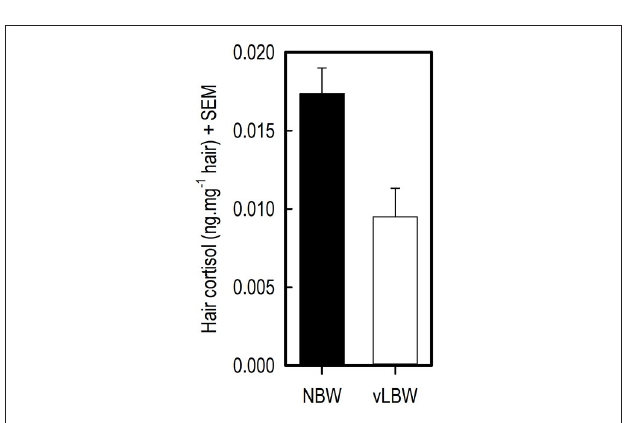
FIGURE 4 | Hair cortisol concentrations (HCCs) in flank hair of 12-week-old NBW ( n = 9) and vLBW ( n = 8) piglets